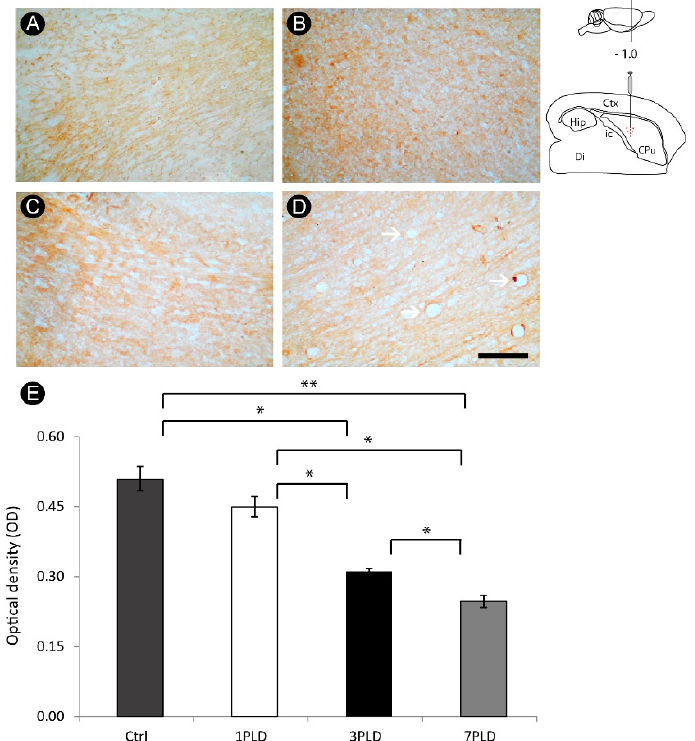
Figure 9. Myelin impairment in the internal capsule following endothelin-1 (ET-1) injection. Control group shows a homogeneous MBP + labeling ( A ). A progressive impairment is observed at 1PLD ( B ), 3PLD ( C ) and 7PLD ( D ), with a noticeable rarefaction of reactivity in the latter survival time. Vacuolization, a hallmark of tissue degeneration, is also evident at 7PLD (arrows). Progressive loss of MBP labeling across time points was confirmed by densitometric analysis ( E ) (* p < 0.05; ** p < 0.01, ANOVA, Tukey post hoc test). Drawings at the left side of the figure show the anatomical localization of the ET-1 injection in the striatum. Ctx: cortex; CPu: caudate putamen (striatum); Di: diencephalon; Hip: hippocampus; ic: internal capsule. Scale bar: 100 μ m.